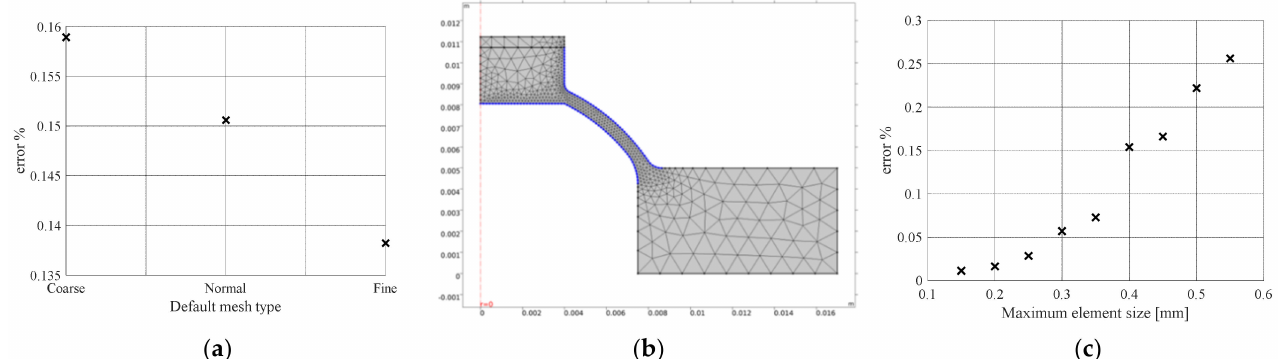
Figure 12. Mesh convergence study: ( a ) quantifies the average percentage error between the curve obtained by setting the mesh extremely fine (considered as reference) and the other default types listed on the x -axis; ( b ) 2D FEM, with mesh defined as normal and customized along the blue edges. ( c ) quantifies the average percentage error between the characteristics curves resulting from varying the maximum size of the mesh elements along the blue